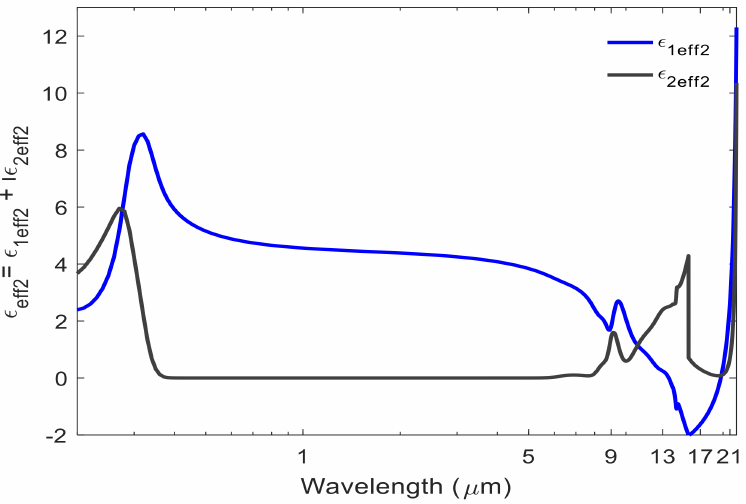
Figure 3. Real part ε 1 ef f 2 and imaginary part ε 2 ef f 2 of dielectric function ε ef f 2 of TiO 2 - SiO 2 composite layer (top) at the filling fraction of